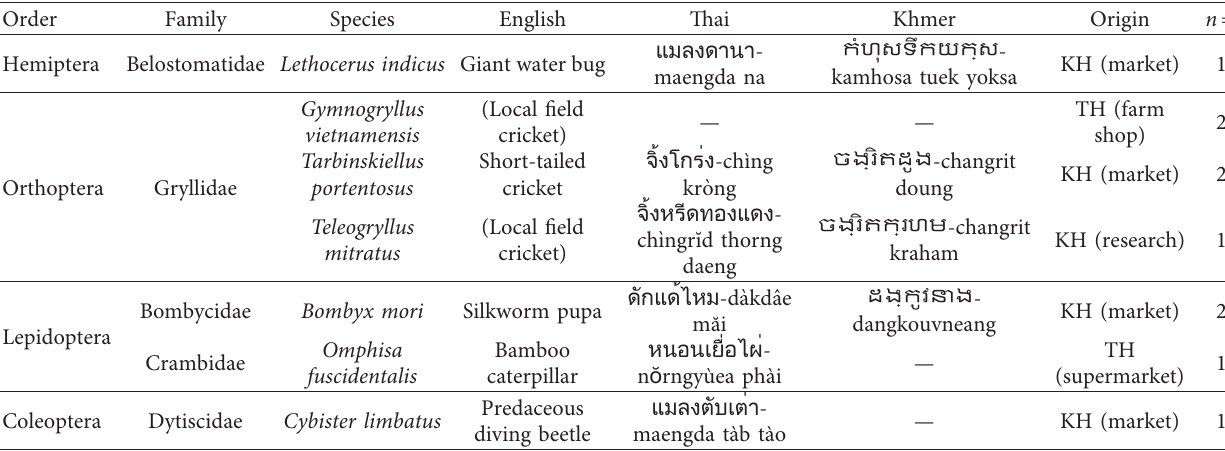
Table 1: Sampled